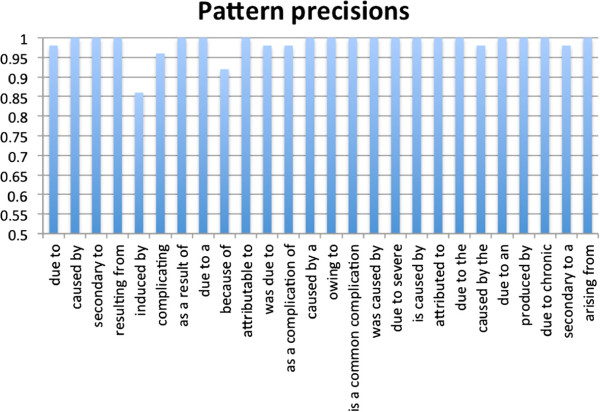
Pattern precisions.